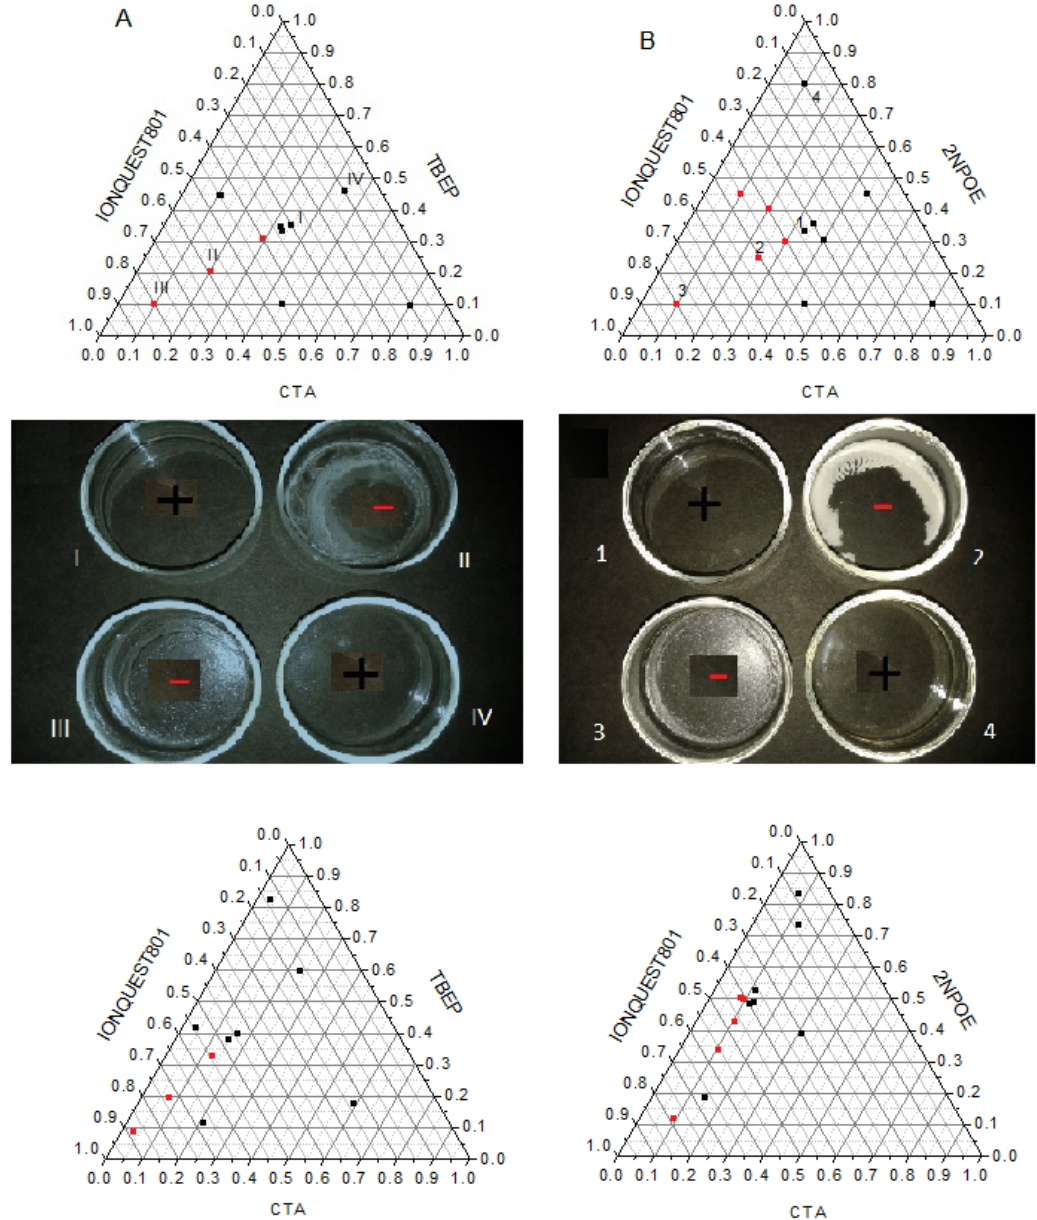
Figure 1. Ternary diagrams for PIMs formation using 2NPOE ( A ) and TBEP ( B ) as plasticizers. Black squares stand for a positive (+) membrane formation while red dots for a negative ( − ) one. Upper diagrams correspond to weight percent while lower diagrams to mole